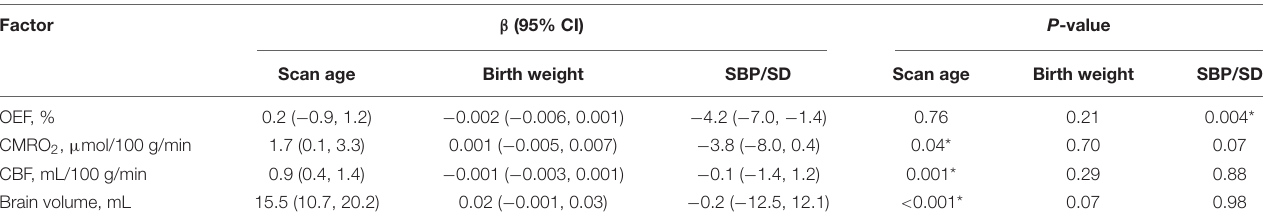
TABLE 3 | Association between maternal SBP (mmHg) and measured physiological parameters ( N = 38).